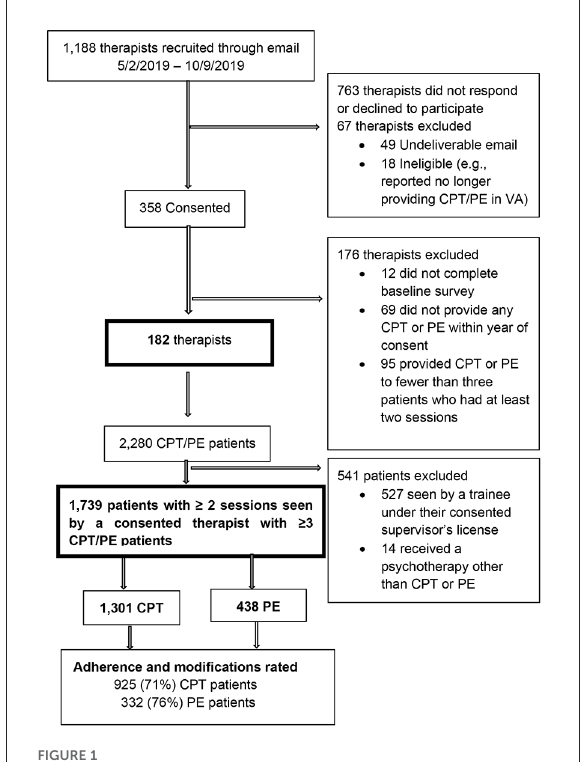
FIGURE1 Flow of participants for adherence and modifications rating.